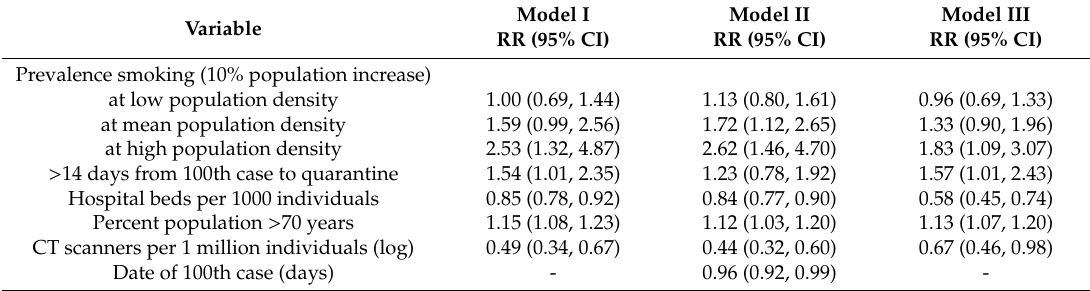
Figure 1. Final model (Model 1) of predicted values plotted against observed values of case fatality rate. These two variables were correlated at r = 0.84. Table 2. Final multivariable negative binomial model predicting case fatality rate. Rate ratios and 95% confidence intervals are presented. Smoking prevalence is evaluated at the mean of (square root transformed) population density, 0.5 SD below (low, approximately 65 per km 2 ), and 0.5 SD above (high, approximately 200 per km 2 ). Model I contains our final estimates without imputation ( n = 26), Model II additionally adjusts for date of 100th case, and Model III shows the results from our final model on imputed CT scanner data ( n =